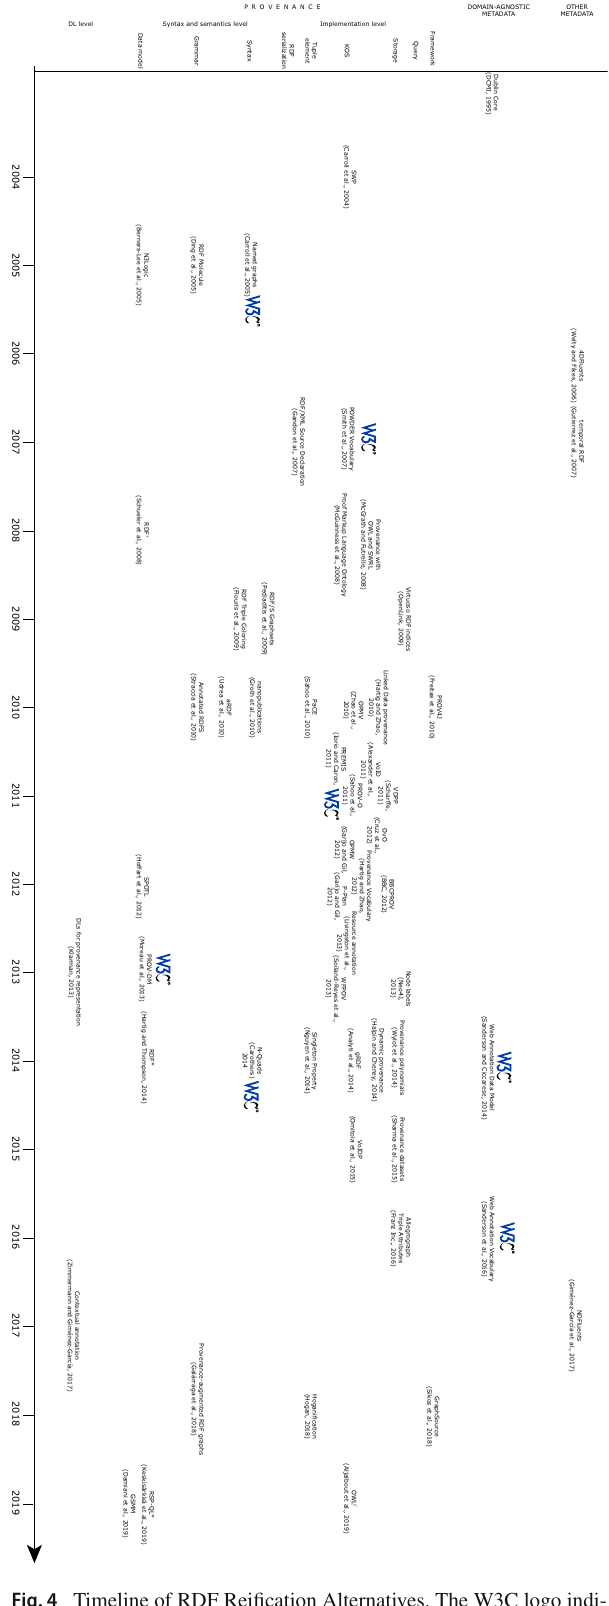
Fig. 4 Timeline of RDF Reification Alternatives. The W3C logo indi- cates standardization (technical specifications) by the World Wide Web